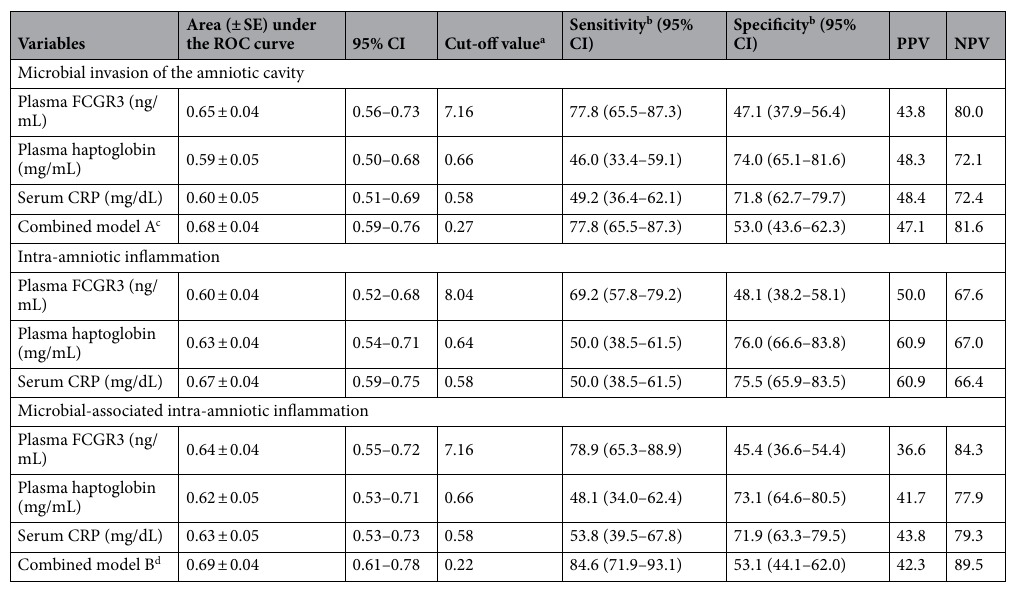
Table 4. Diagnostic indices of various plasma biomarkers to predict microbial invasion of the amniotic cavity, intra-amniotic inflammation, and microbial-associated intra-amniotic inflammation. SE standard error, ROC receiver-operating characteristic, CI confidence interval, PPV positive predictive value, NPV negative predictive value, FCGR3A low affinity immunoglobulin gamma Fc region receptor III-A, CRP C-reactive protein. a Cut-off values corresponding to the highest sum of sensitivity and specificity. b Values are given as % (95% CI). c Combined model A consists of plasma FCGR3 and serum CRP levels. d Combined model B consists of plasma FCGR3 and serum CRP